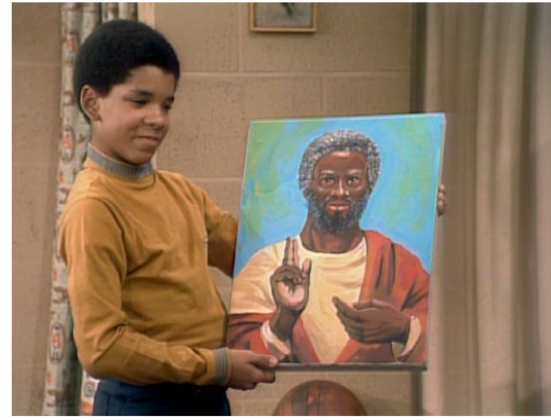
Figure 3. Michael Evans holds J.J.’s painting of Black Jesus. Screenshot captured from “Thank You Black Jesus.” Good Times: The Complete First Season , Columbia Tristar Home Entertainment,